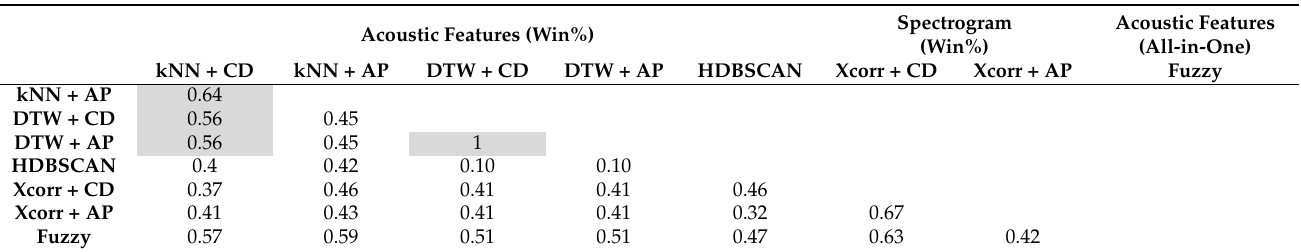
Table 5. Comparison of the determined giant otter vocalization labels using NMI. NMI values are shaded if NMI > 0.5 and ∆ Cluster ≤ 1.